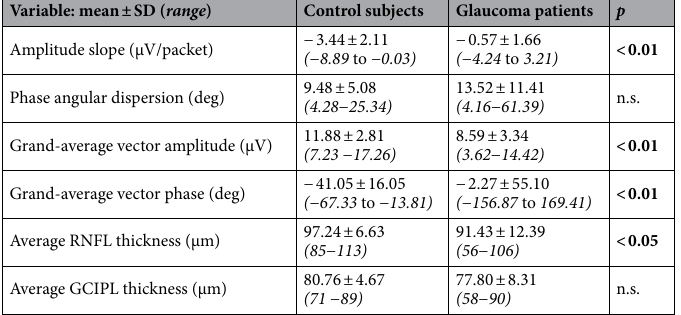
Table 2. Descriptive analysis of the main outcome measures of the study. The statistical significance ( p value) of t -test comparisons between group parameters is shown.